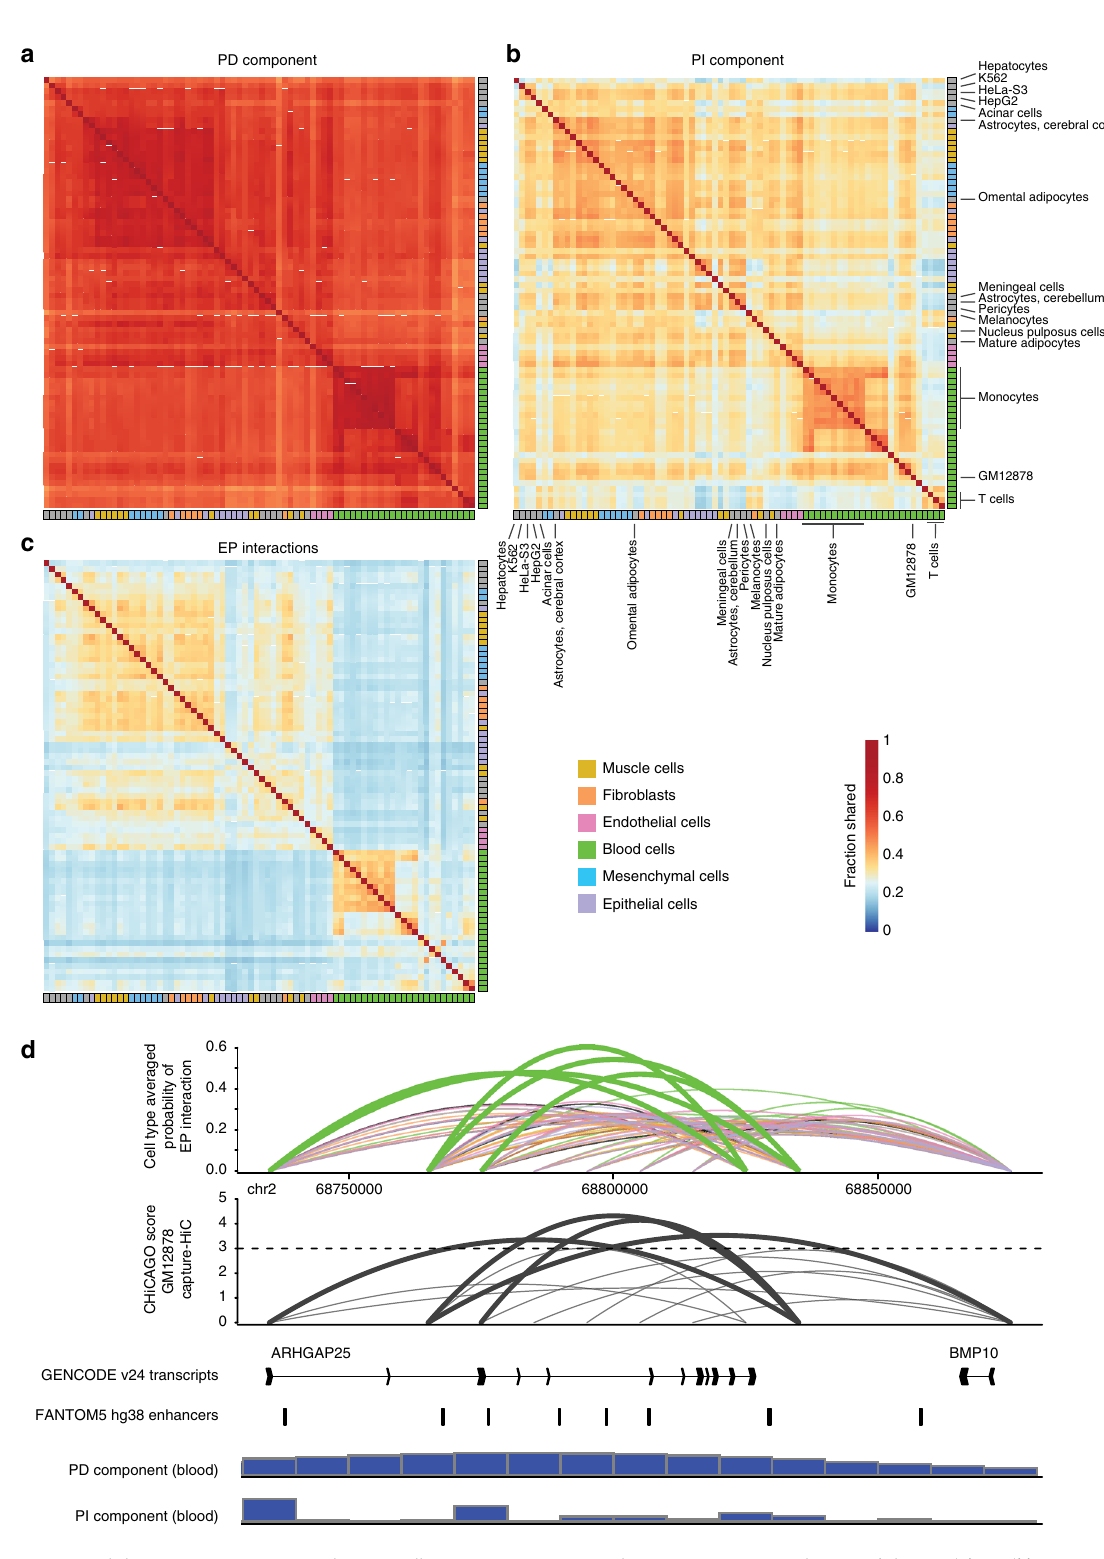
Fig. 6 Transcriptional decomposition across 76 human cell types. a – c Heat maps depicting pairwise similarities of the PD ( a ), PI ( b ) components and EP interactions ( c ) across cell types. All similarity scores were calculated between cell types using 1 – L 1 norm on binary data sets based on the sign of the PD, PI components or the presence/absence of EP interactions. Cell-type ordering is fi xed according to the results of a hierarchical clustering (complete linkage) of the raw expression data. d Predicted probability of EP interactions averaged across groups of cells and CHiCAGO score of interaction based on GM12878 capture HiC data. GENCODE v24 transcripts, FANTOM5 enhancers and the average PD and PI component across blood cells are displayed